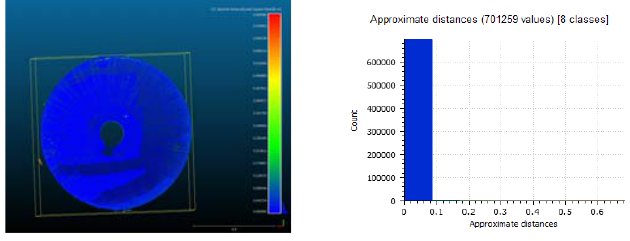
Figure 15: Discrepancy (m) map and histogram between the TLS point cloud and Regard 3D